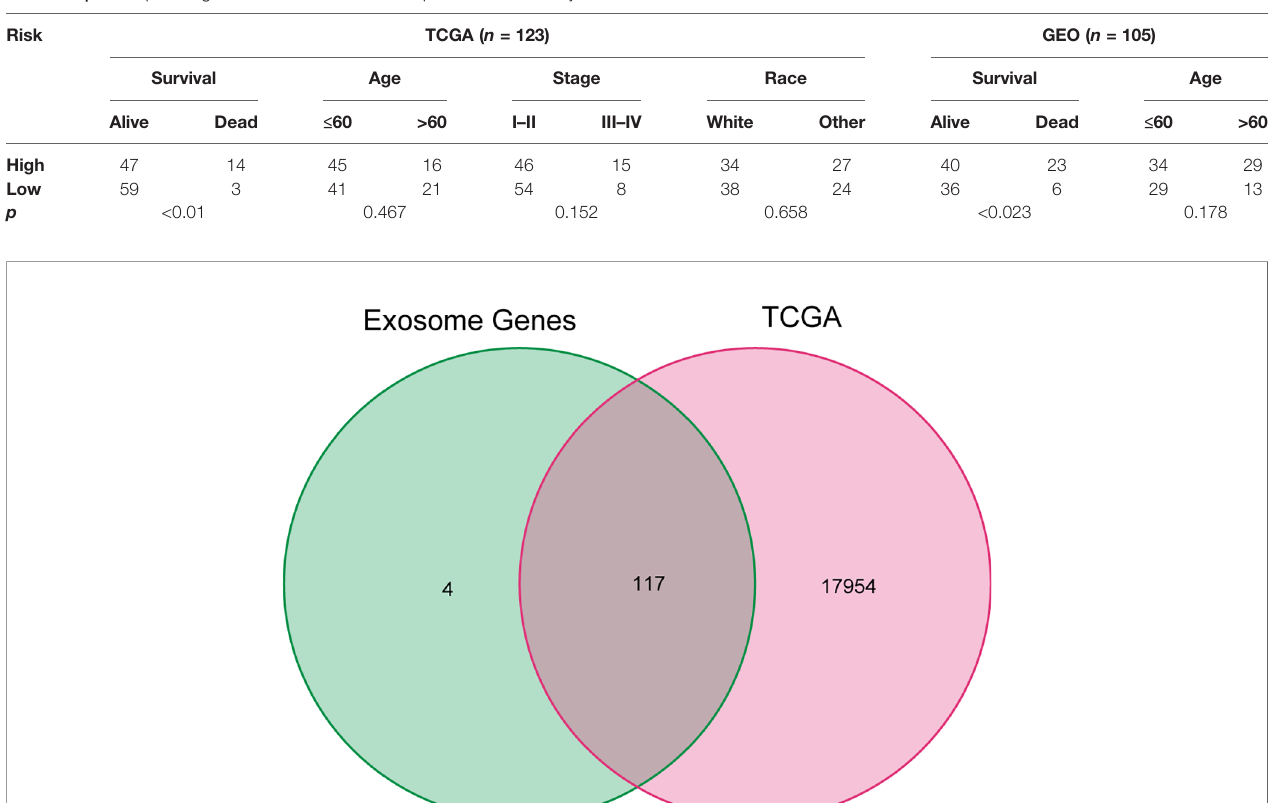
TABLE 1 | Clinicopathological characteristics of TNBC patients in this study.